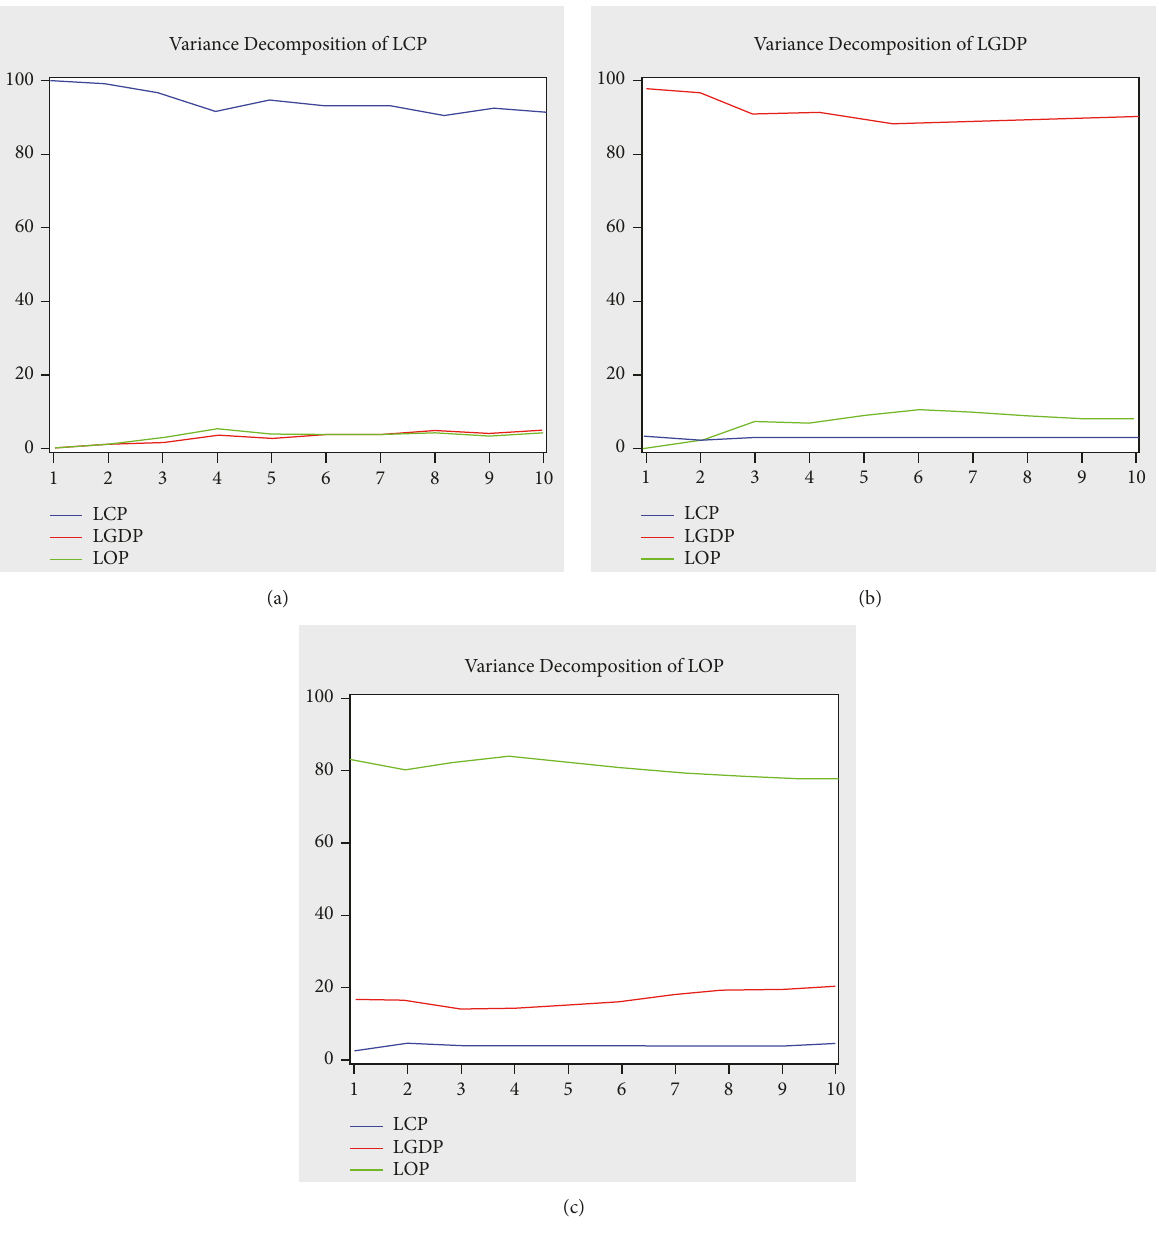
Figure 6: Variance